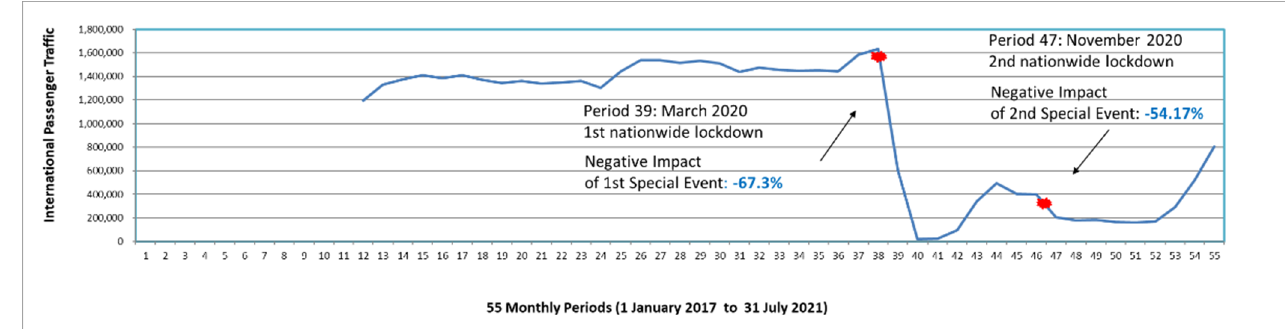
Figure 8. Impact of Special Events on international pax traffic in AIA.